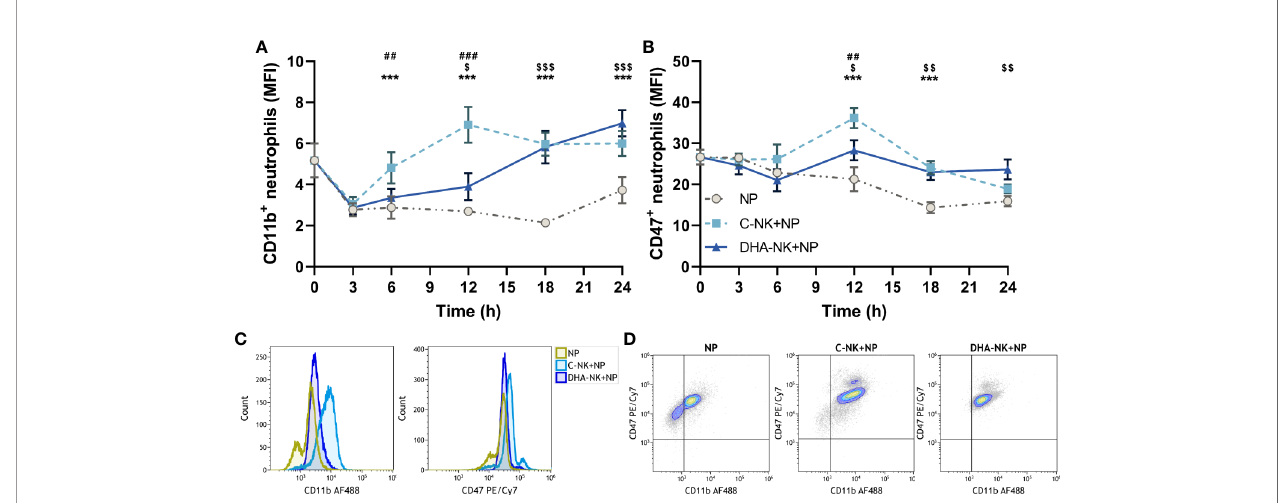
FIGURE 1 | The effects of NK cells and NK cells pre-incubated with DHA on neutrophil expression of CD11b (A) and CD47 (B) . Neutrophils were culture alone (NP) or with NK cells that had been pre-incubated for 18 h without (C-NK+NP) or with 50 µM of docosahexaenoic acid (DHA-NK+NP) and then stimulated with IL-2 (2 ng/ ml), IL-12 (2 ng/ml), and IL-15 (10 ng/ml). The cells were cultured together for 0, 3, 6, 12, 18, and 24 h. Expression levels were determined by fl ow cytometry and are presented as mean fl uorescence intensity (MFI). Representative overlay histograms of CD11b and CD47 expression levels at 12 h (C) . Representative dot plots of expression levels of CD11b and CD47 at 12 h (D) . Positive gating was determined with appropriate isotype controls. Data are shown as mean ± SEM; * indicates difference between C-NK+NP and NP, $ difference between DHA-NK+NP and NP, and # difference between DHA-NK+NP and C-NK+NP. One symbol indicates p < 0.05, two symbols p < 0.01, and three symbols p < 0.001. n = 6 (independent donors), collected in three independent